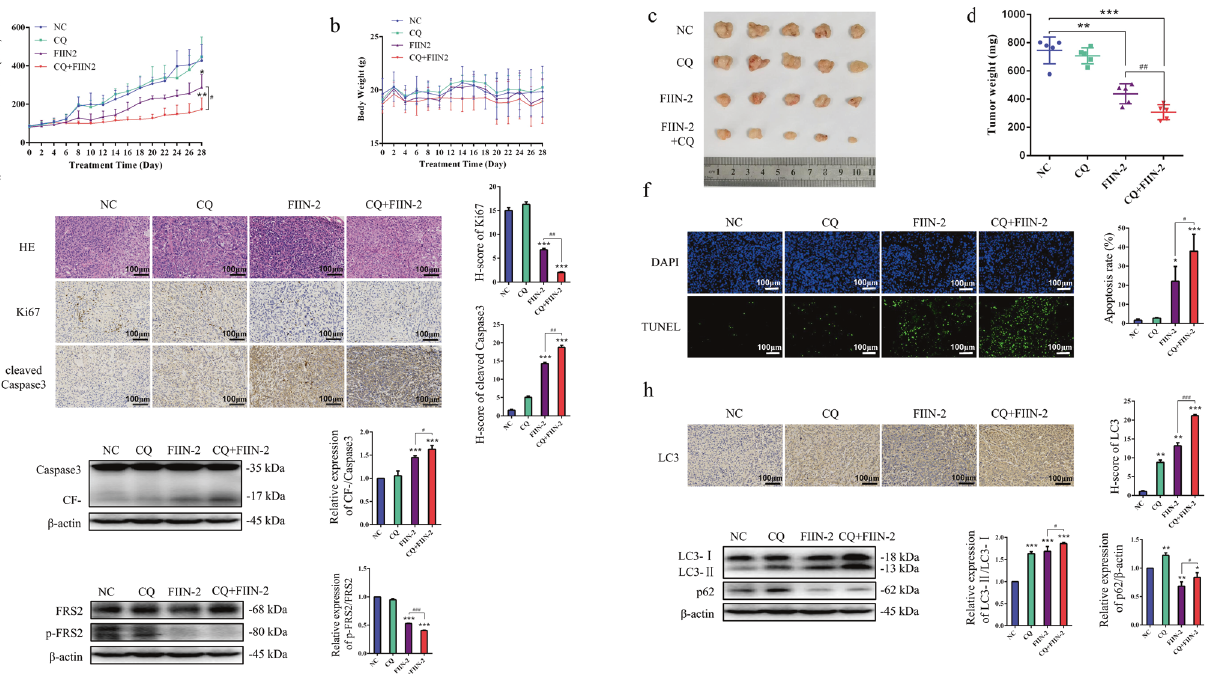
Fig. 6 The anti-LUAD effect of FIIN-2 alone and combined with CQ in xenograft models derived from A549/DDP cells. The nude mouse xenograft model derived from A549/DDP cells was established. They were treated with vehicle control (100 μ L saline solution, qd.), CQ (30 mg/ kg, qd.), FIIN-2 (20 mg/kg, bid.), or FIIN-2 (20 mg/kg, bid.) combined with CQ (30 mg/kg, qd.) via intraperitoneal injection for 28 consecutive days. The tumour volume ( a ) and body weight ( b ) of the mice were measured every other day. c Tumours were removed and imaged. d The tumour weight of each group was calculated. e Immunohistochemical staining and/or western blot analysis were performed to detect the expression of the proliferation marker Ki67 and proapoptotic molecule cleaved Caspase-3. f A TUNEL assay was used to detect cell apoptosis. g The expression of p-FRS2 was detected by western blot analysis. h The expression of the autophagy markers LC3 and p62 was detected by immunohistochemical staining and/or western blot analysis. Magni fi cation 200×, scale bars: 100 μ m. Each measurement is an average ± SD ( n = 5). * p < 0.05, ** p < 0.01, *** p < 0.001; # p < 0.05, ## p < 0.01, ### p <